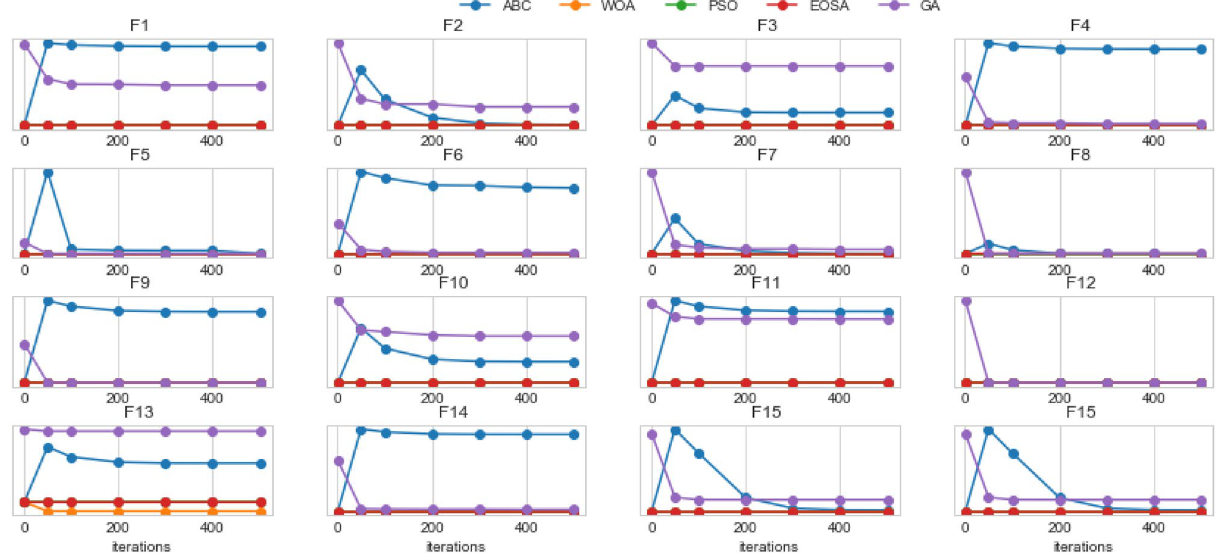
Figure 6. Comparison of convergence curves of the performance of EOSA, ABC, WOA, PSO, and GA optimization algorithms on all standard benchmark functions applied in this study.